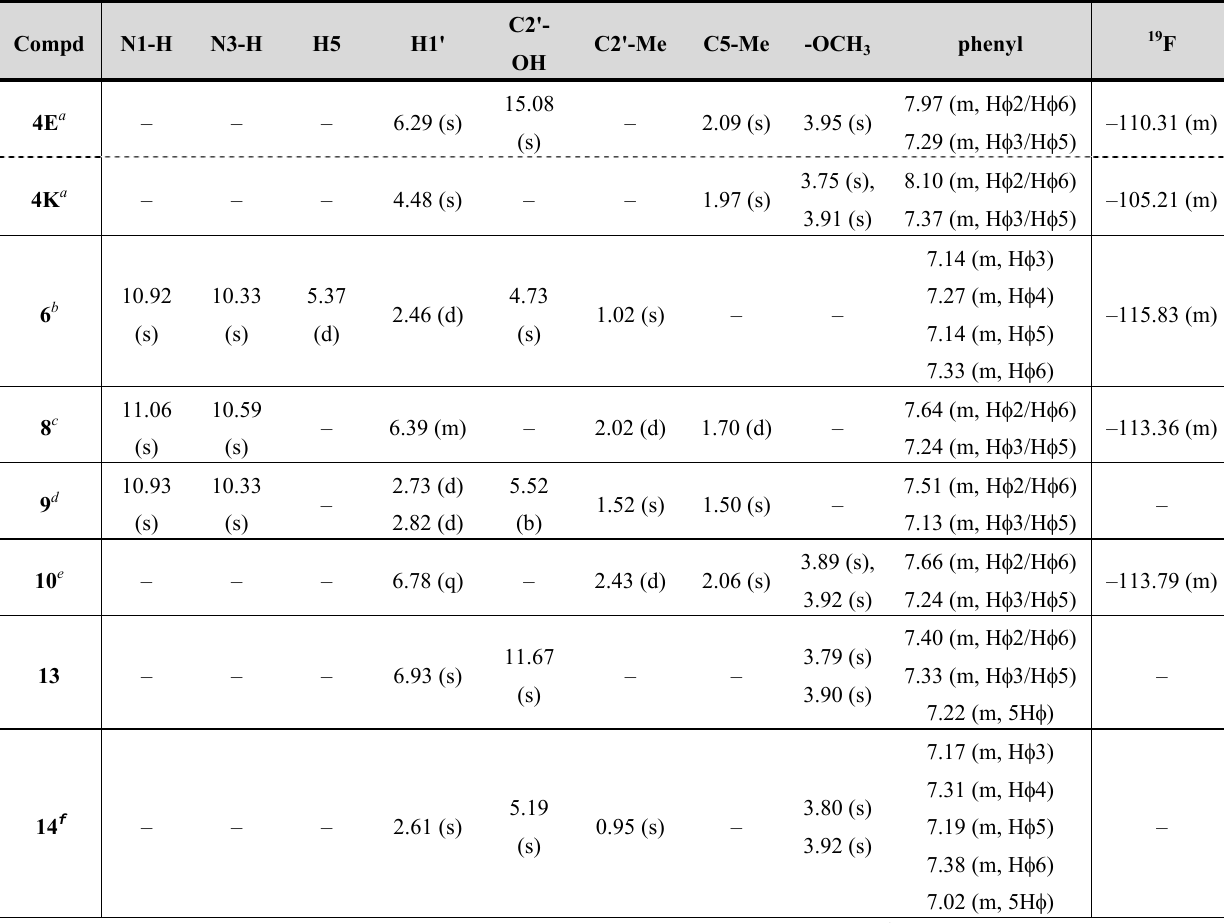
Table 2. 1 H- and 19 F-NMR chemical shifts ( δ /ppm), signal multiplicities and H-H coupling constants ( J